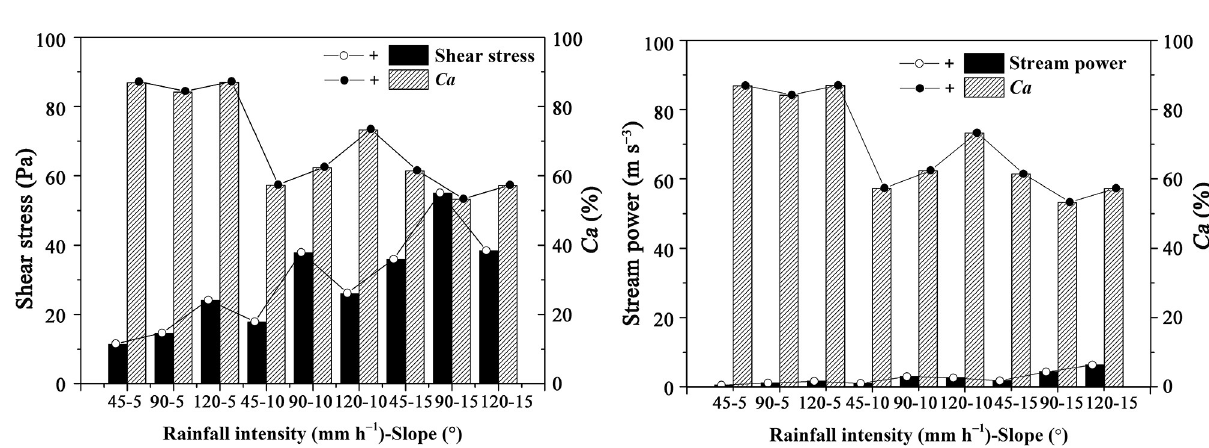
Fig 7. Relationships of shear stress, stream power and the contributions of unevenly enriched OC in sediments to the SOC enrichment ratios in sediments ( Ca ).